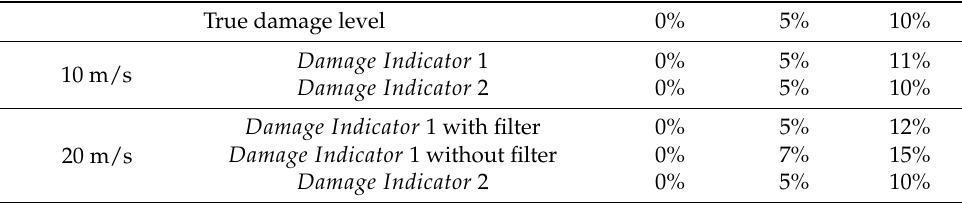
Figure 8. Mean calculated MR-ILs with different damage at different speed: ( a ) 10 m/s; ( b ) 20 m/s. Table 3. Inferred damaged indicators and true damage